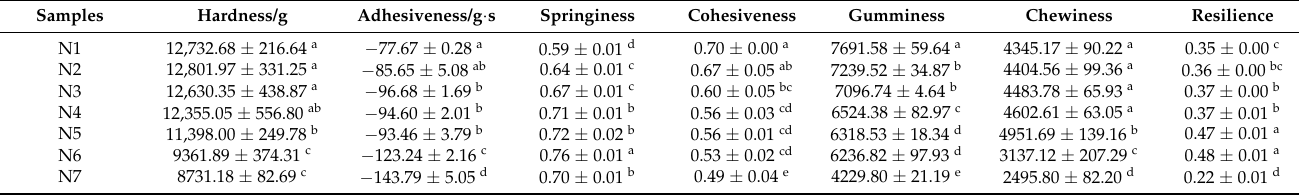
Table 3. Texture index of tartary buckwheat